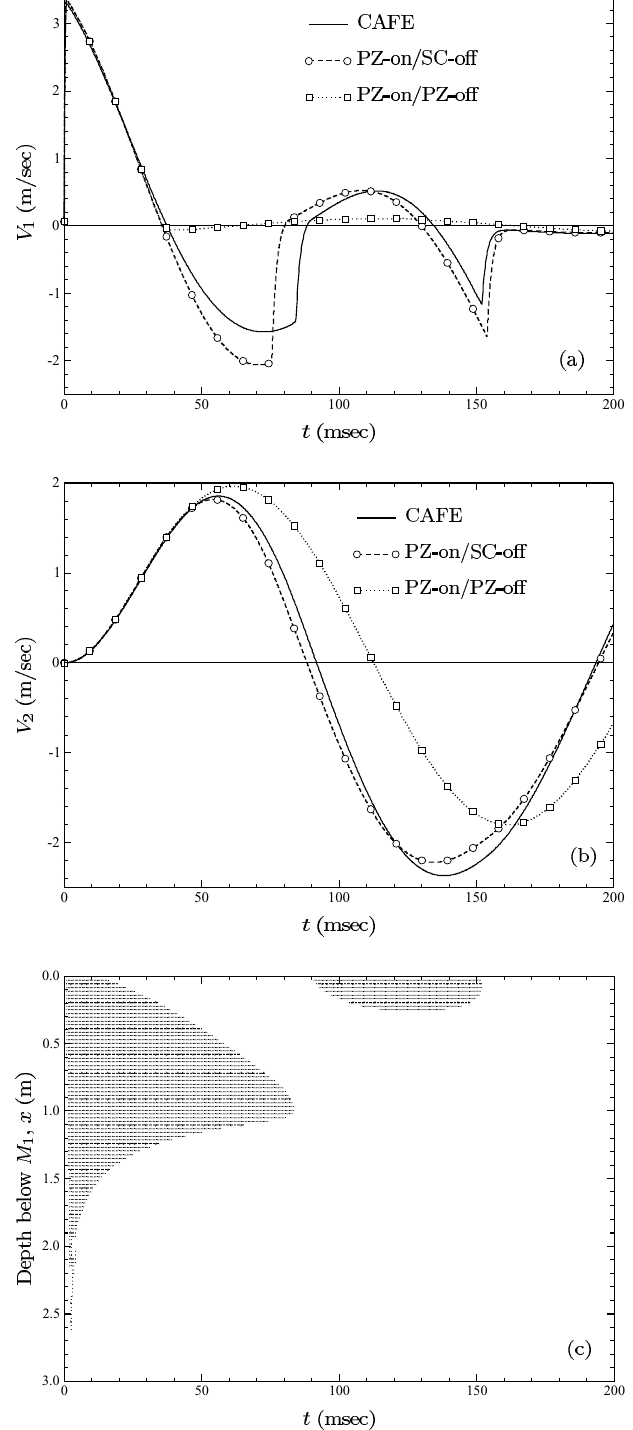
Fig. 5. (a) V 1 - and (b) V 2 -response histories for M 2 /M 1 = 1 , demonstrating the performance of two WSAs(PZ– Pressure Zero, SC – Separation Closure). (c) Cavitation